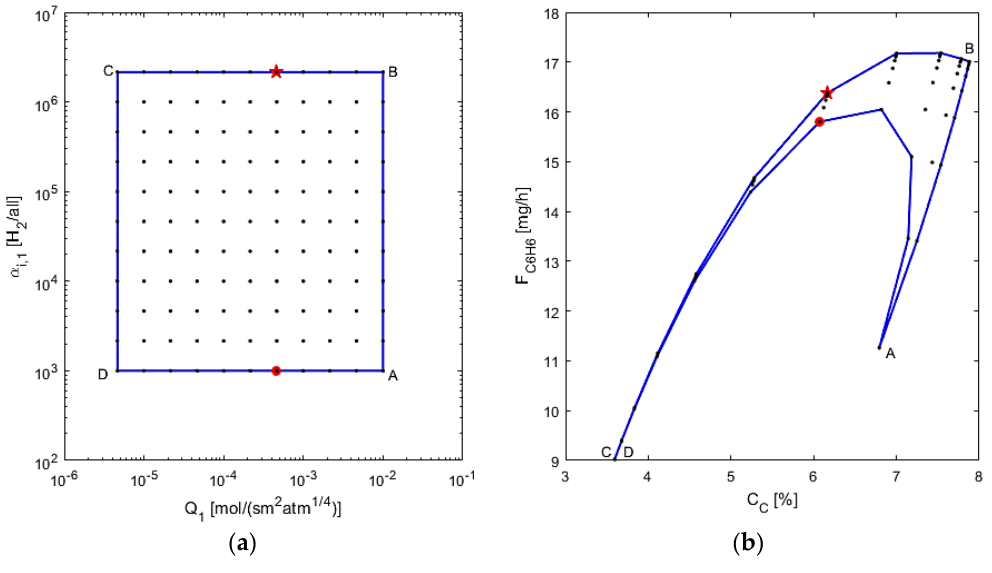
Figure 10. ( a ) AIS—M1 permeance and selectivity to hydrogen; ( b ) AOS—C C and F C6H6 .